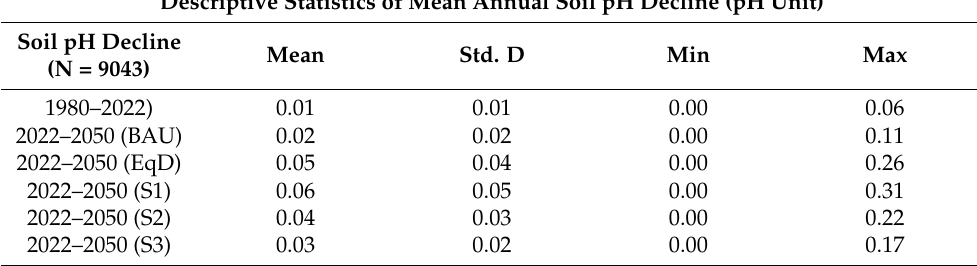
Table 1. Descriptive statistics of estimated soil pH decline in SSA.